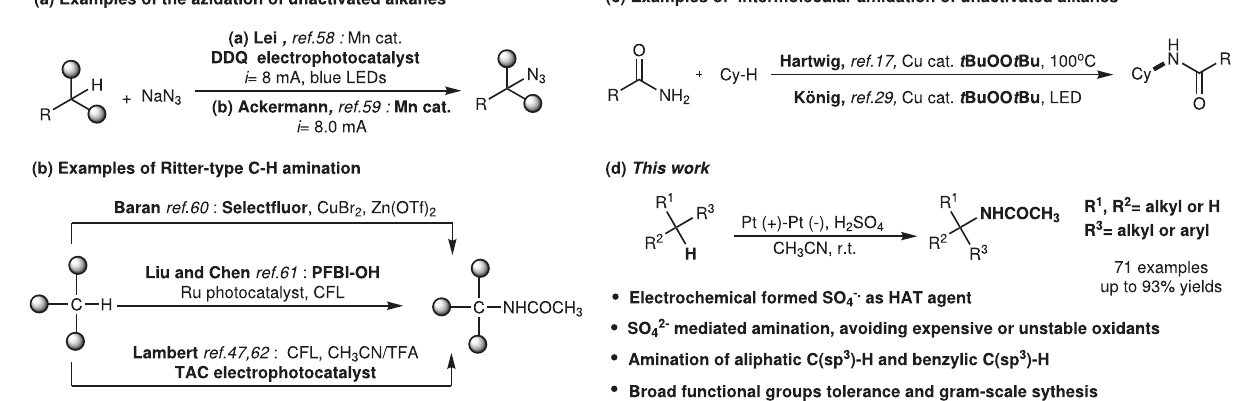
Fig. 1 Examples of C(sp 3 )-H amination reactions. a Examples of the azide reaction of unactivated alkanes via (photo)electrocatalysis. b Examples of Ritter- type C-H amination via Select fl uor, hypervalent iodine reagent and TAC electrophotocatalyst. c Examples of intermolecular amidation of unactivated alkanes via t BuOO t Bu and Cu cat. d This work: Ritter-Type amination of C(sp 3 )-H bonds enabled by the electrochemistry with SO 4 2 − . Table 1 Optimization of reaction